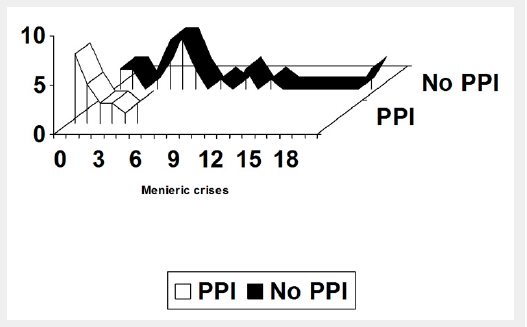
Frequency plot of menieric crises in the two groups of study.